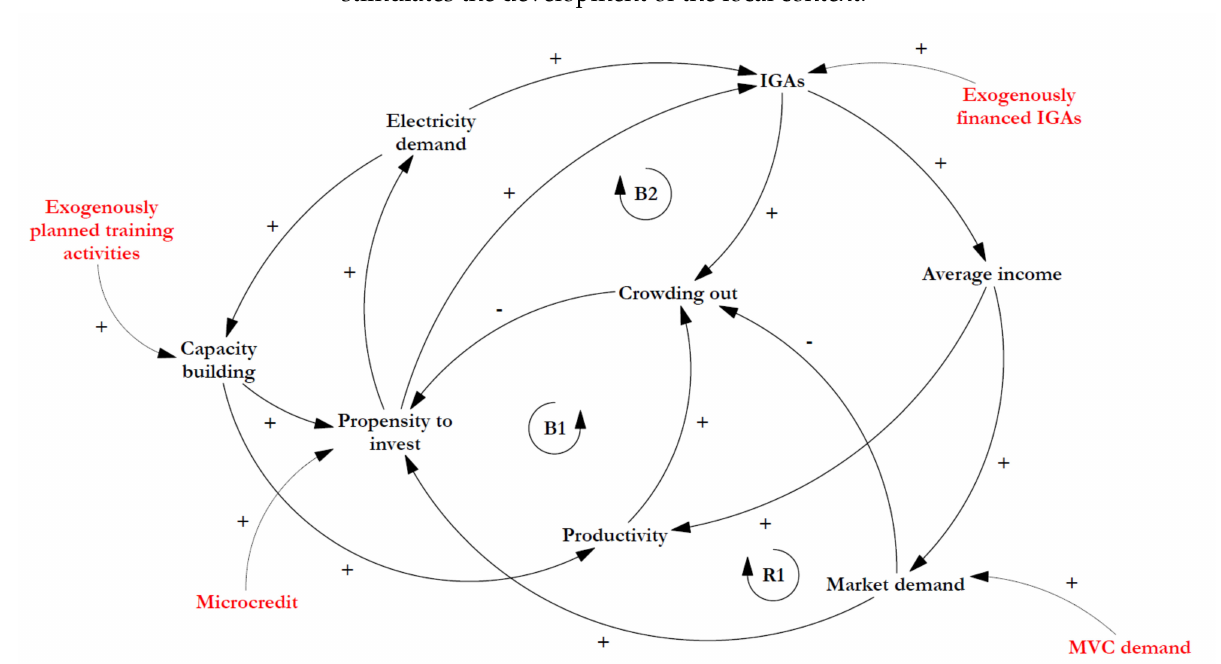
Figure 1. Causal loop diagram showing the role of complementary actions (reported in